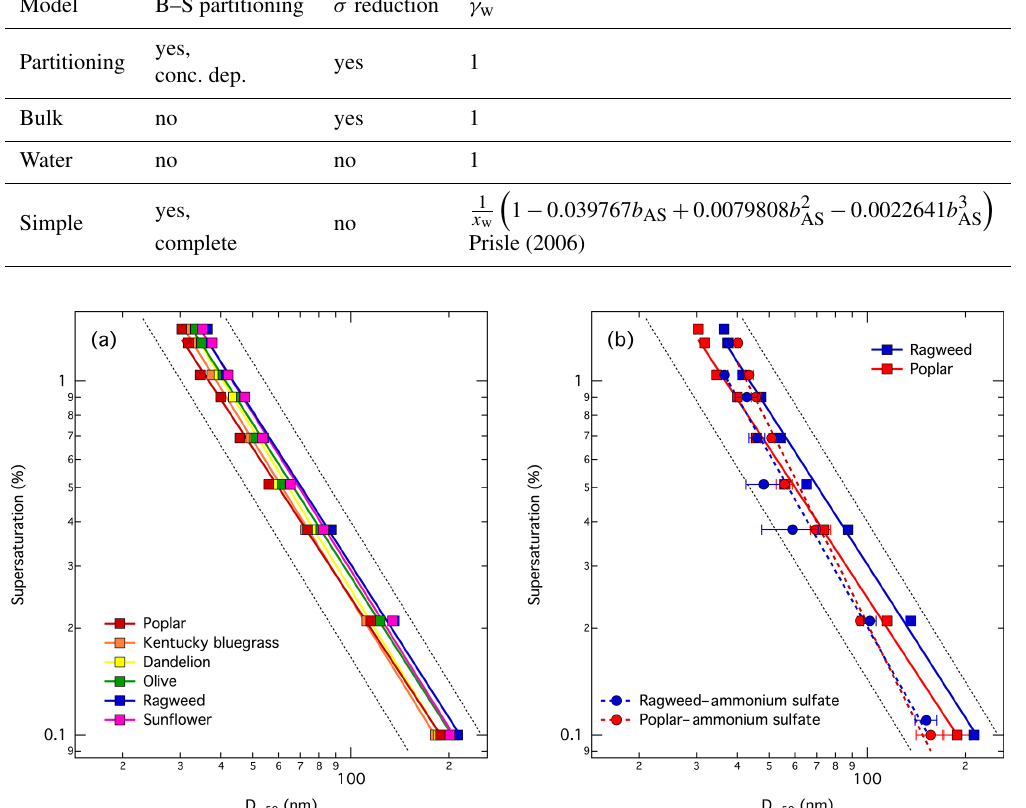
Figure 1. Measured CCN activity in terms of critical dry diameter ( D p , 50 ) vs. supersaturation (SS) for particles comprising (a) six pure pollenkitts, and (b) mixtures of poplar and ragweed pollenkitt with 20% by mass of ammonium sulfate, shown together with results for the respective pure pollenkitt particles. Lines are fitted to the data to determine the slope in double-logarithmic space. Dashed black lines have slopes of − 3 / 2 and are shown on the graphs to guide the